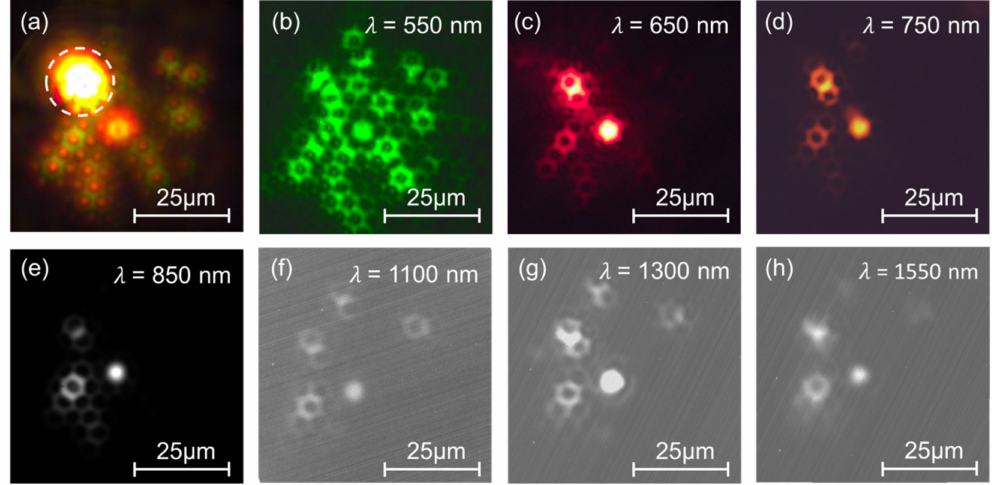
Figure 6. The spatial profile of the output of SC generated inside the core: ( a ) Multispectral and filtered for the marked wavelengths ( b – h ). The encircled area of the picture in (a) shows a place where the air-hole glass size and spacing strongly enhance SC